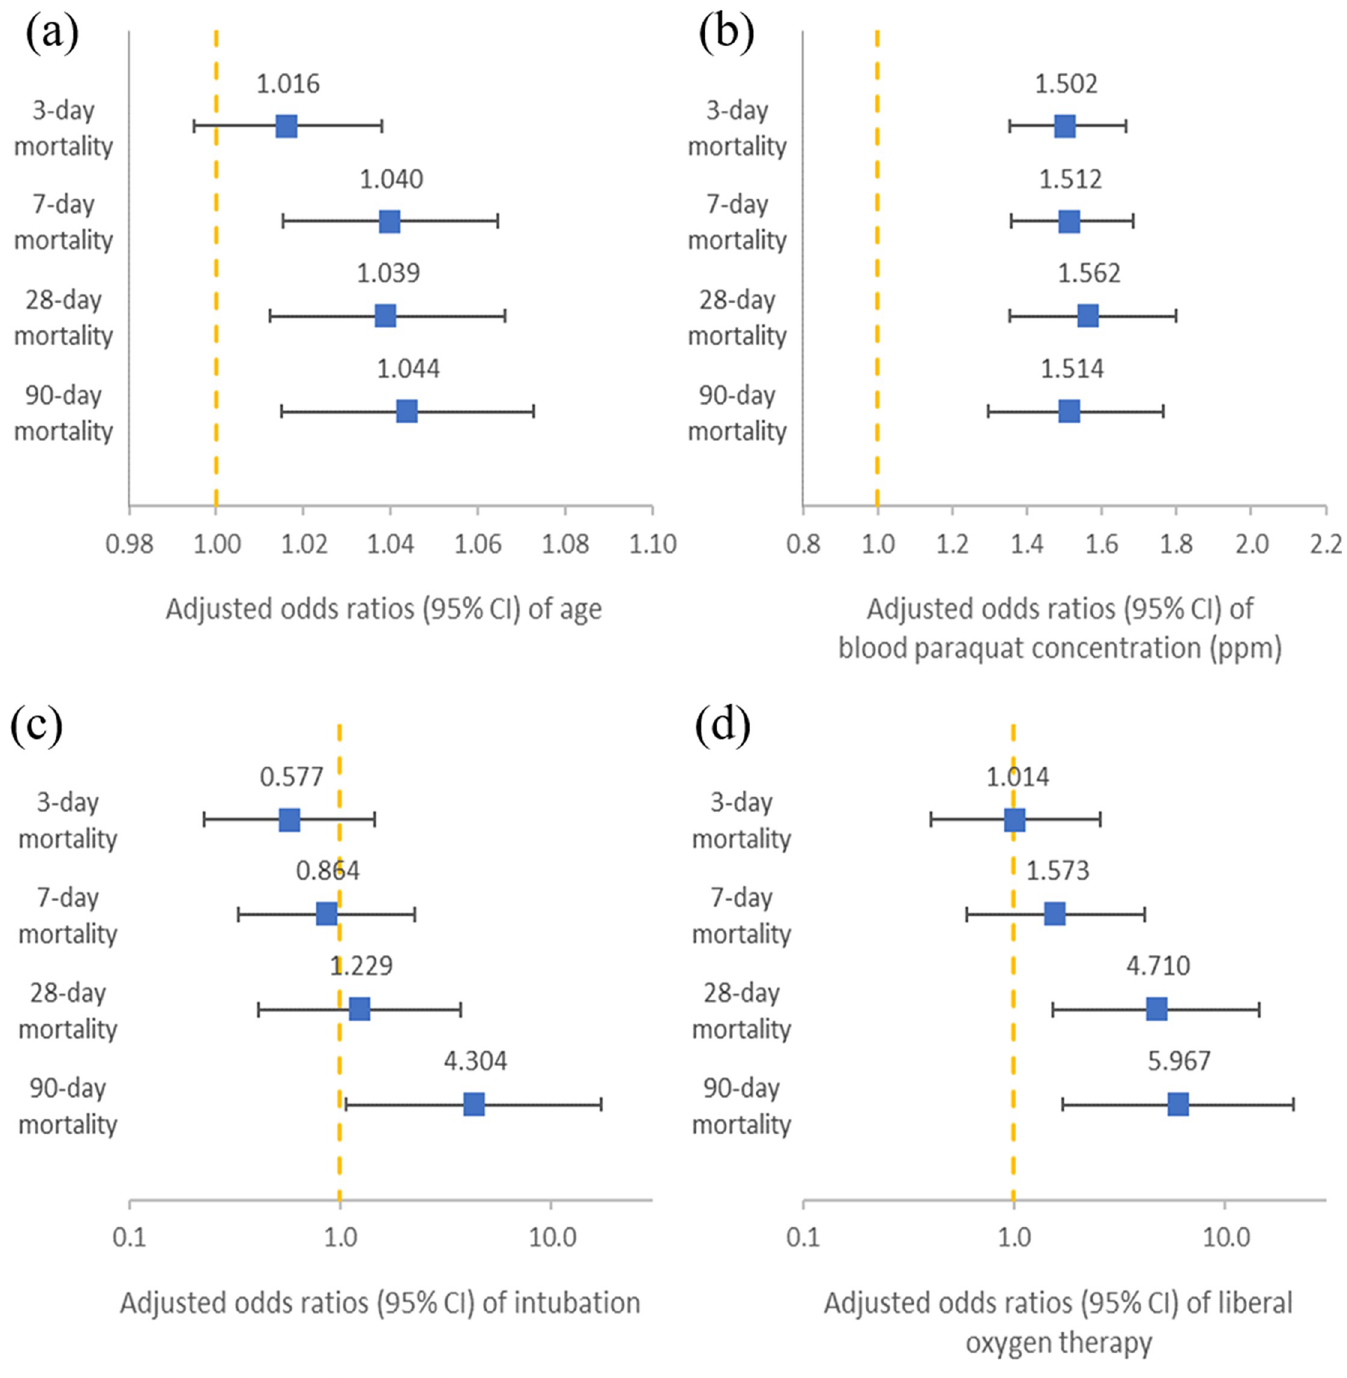
Fig 2. Adjusted odds ratios between different mortality